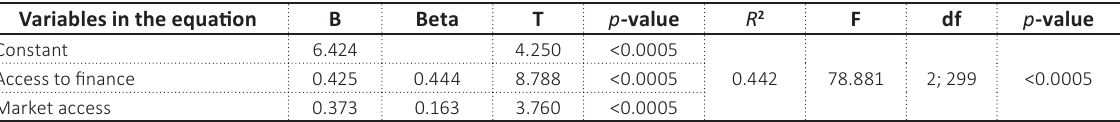
Table 2. Output of regression analysis on access to the market and access to finance as predictors of SMEs’